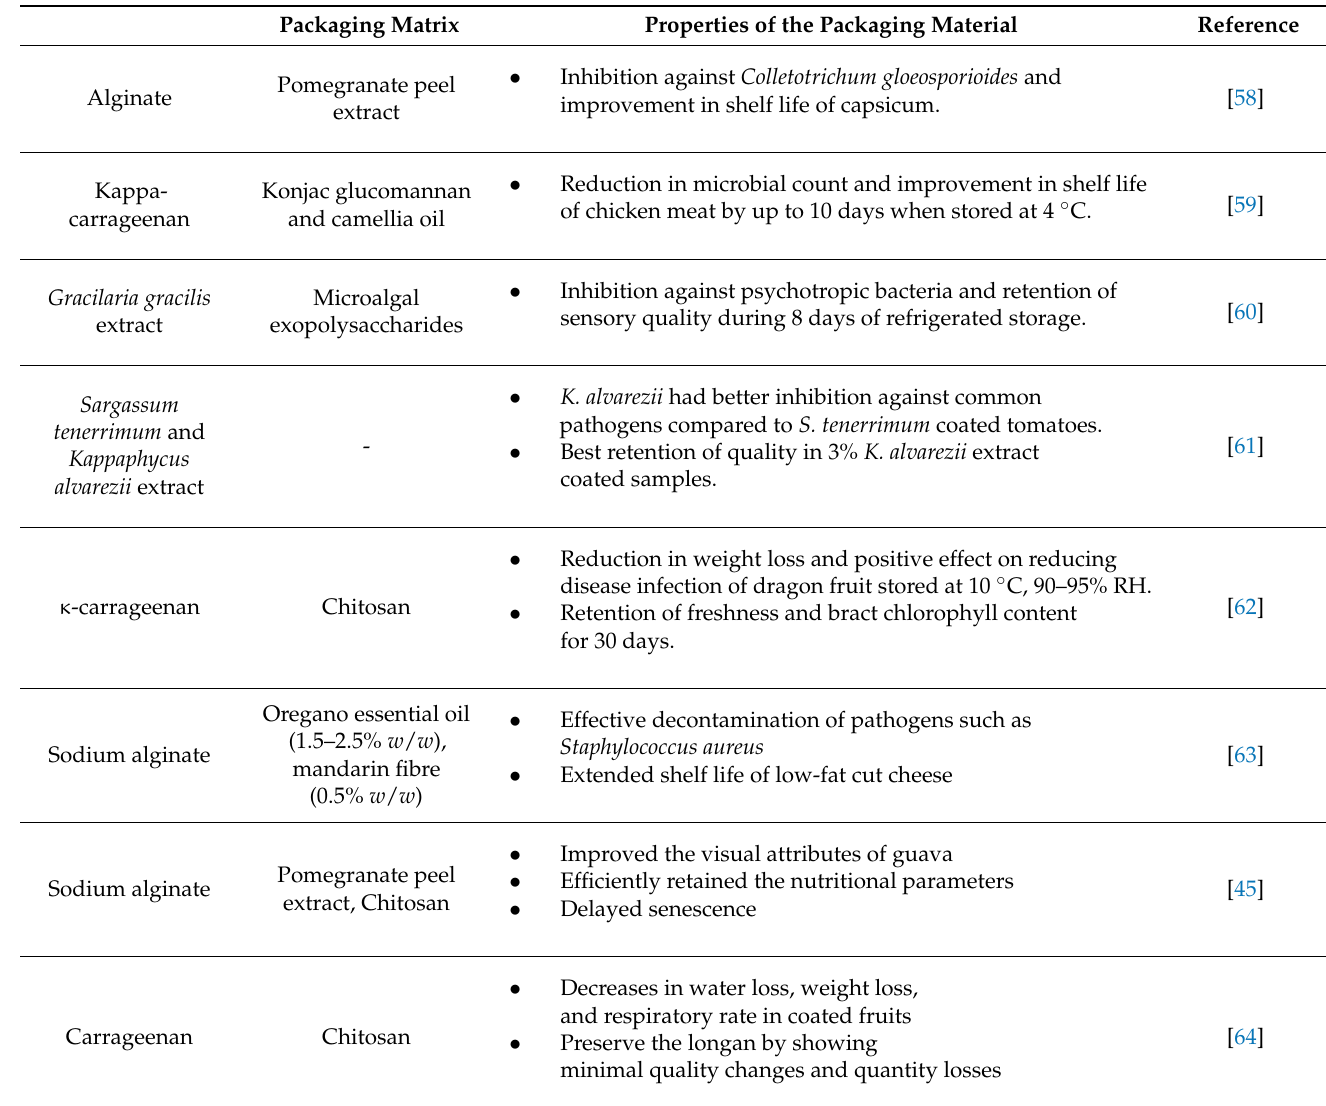
Table 4. Instances of seaweed polysaccharides in